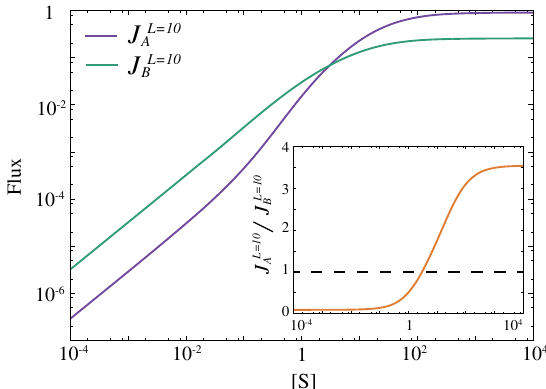
FIG. 8. J L ¼ 10 and J L ¼ 10 are plotted against the substrate B A concentration [ S ]. The ratio of J L ¼ 10 to J L ¼ 10 is also plotted B A in the inset of the figure. Parameters for the polymer elongation ˆ k 10 5 , ˆ k 10 2 , part are set to ˆ v ¼ 0 . 1 , ρ C ¼ 1 . 0 , ρ D ¼ 10 . 0 , 0 ¼ 1 ¼ ˆ